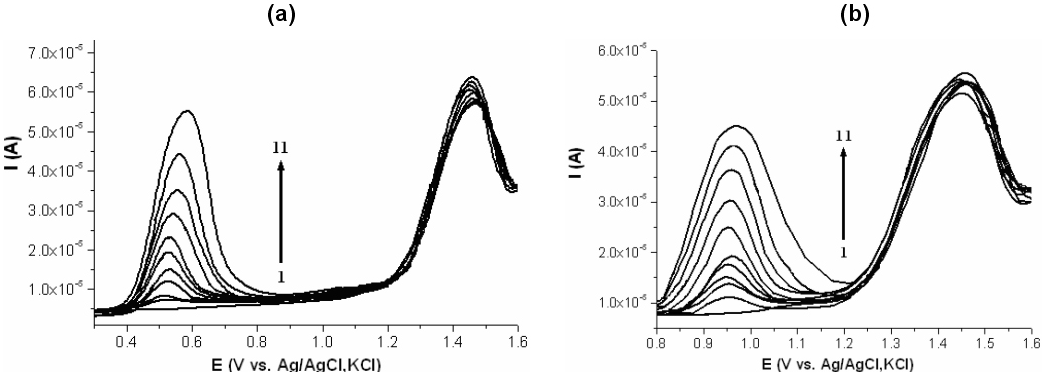
Figure 7. Differential pulse voltammograms on electrochemically activated glassy carbon electrode for (a) a 10 -3 mol L -1 caffeine solution in the presence of different paracetamol concentrations: (1) 0, (2) 10 -6 , (3) 5×10 -6 , (4) 10 -5 , (5) 5×10 -5 , (6) 7.5×10 -5 , (7) 10 -4 , (8) 2.5×10 -4